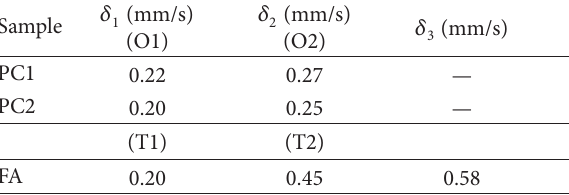
T 4: Mössbauer parameters of the initial